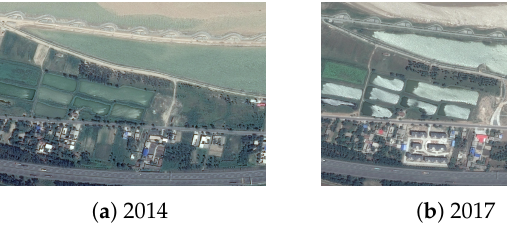
Figure 7. Weihe Dataset.